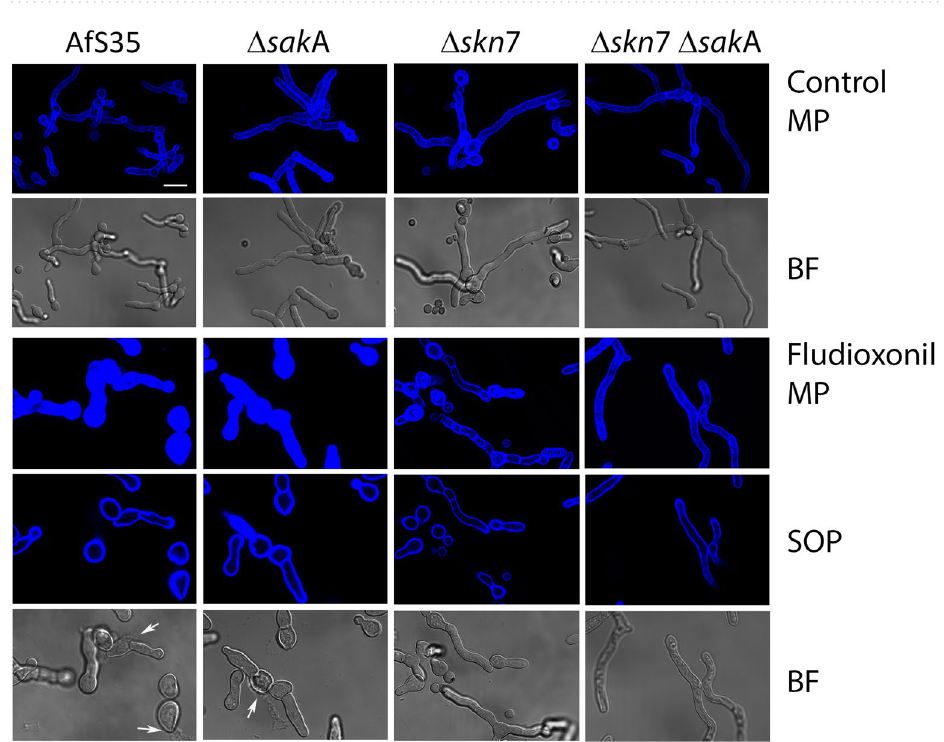
Figure 7. Analysis of fludioxonil-induced changes of the chitin content in the cell wall. Resting conidia of the indicated strains were cultivated in AMM with or without fludioxonil (1 µg/ml) for 16 h at 37 °C. Samples were fixed and stained with CFW, the corresponding bright field images were also shown. MP = maximum intensity projections of z-stacks. SOP = Single optical planes of the corresponding z-stack. BF = bright field image. Lysing cells are indicated by arrows. The bar in the upper left panel represents 10 µm and is valid for all